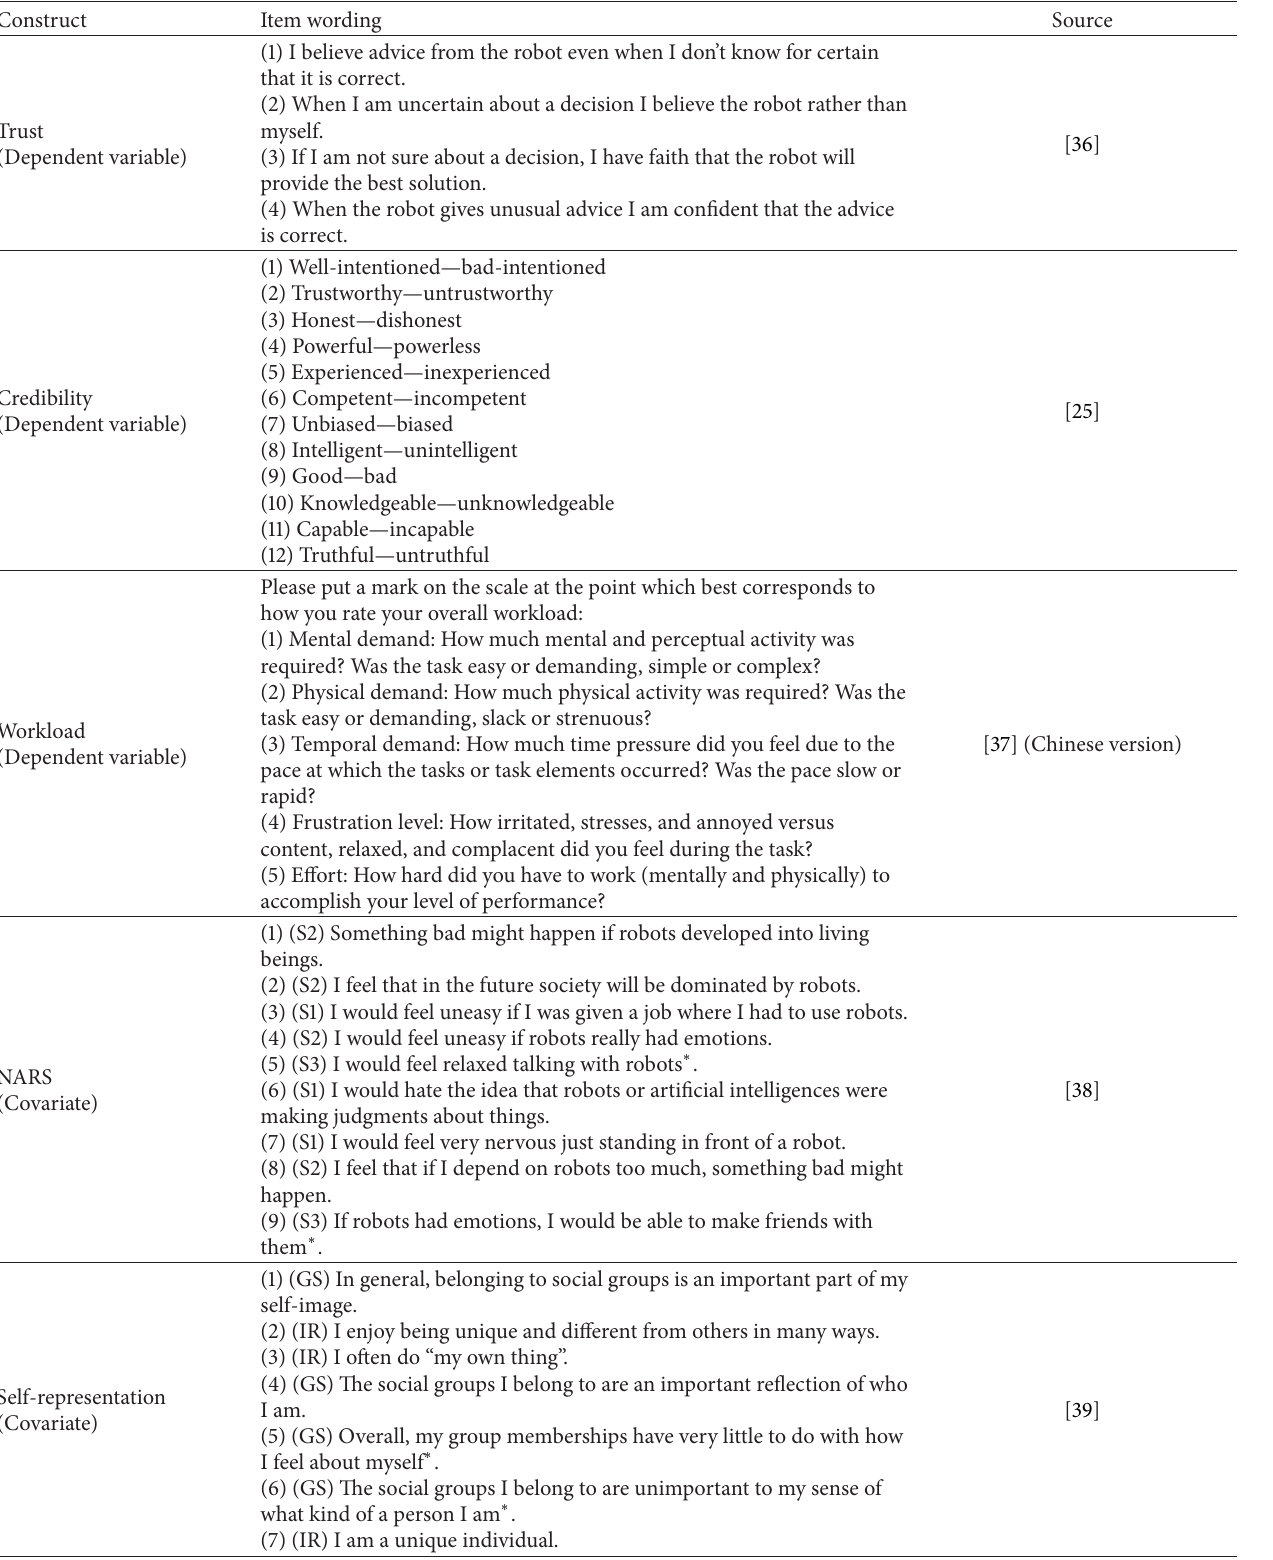
Table 4: Subjective items of the